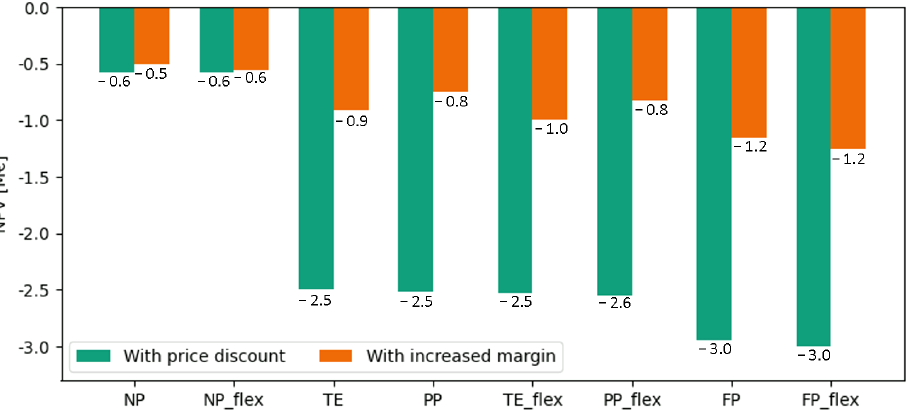
Figure 8. NPV of REC-OC after 25 years of operation for different scenarios. Green bars show the NPV with all benefits passed down to the consumer reducing the individual energy bill. Orange bars show the NPV with no consumer price discount but instead using the additional earnings to repay the